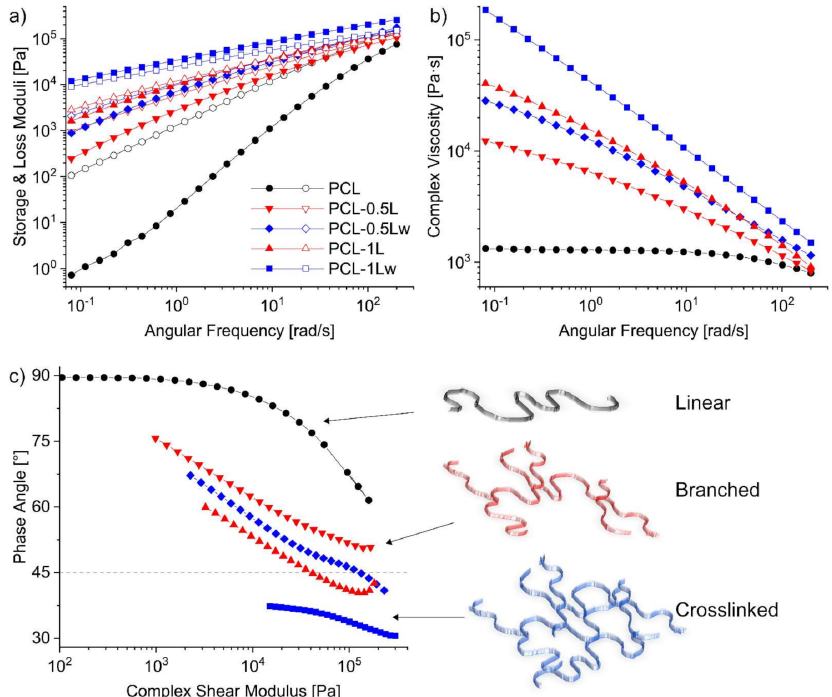
Figure 6. Dynamic rheological behavior in frequency sweeps at 120 ◦ C of neat and reacted PCL: ( a ) storage (full symbols) and loss (empty symbols) moduli; ( b ) complex viscosity; ( c ) Van Gurp-Palmen plot showing phase angles as a function of complex modulus, phase angles below 45 ◦ indicate predominant